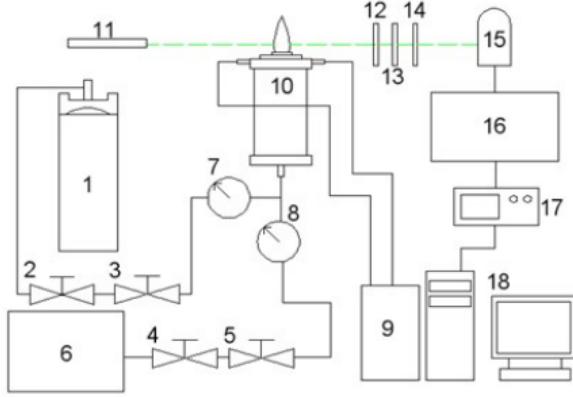
Figure 2: Scheme of the experimental apparatus. 1) Fuel vessel,